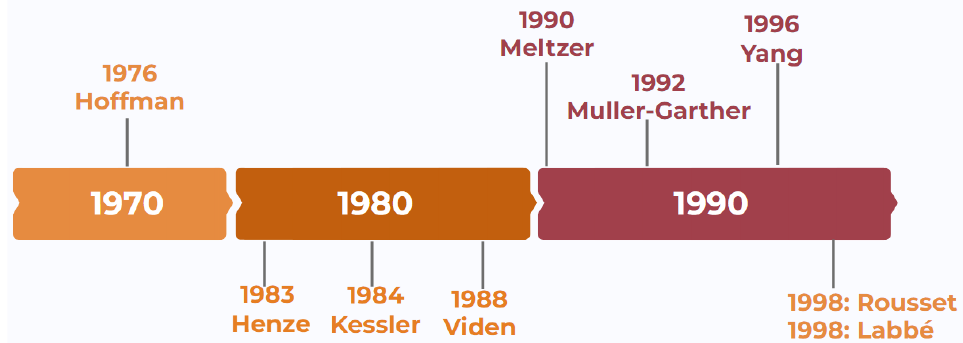
Figure 1. Historic chronogram of the presentation of several Partial Volume Correction (PVC) methods throughout the last decades of the last century.